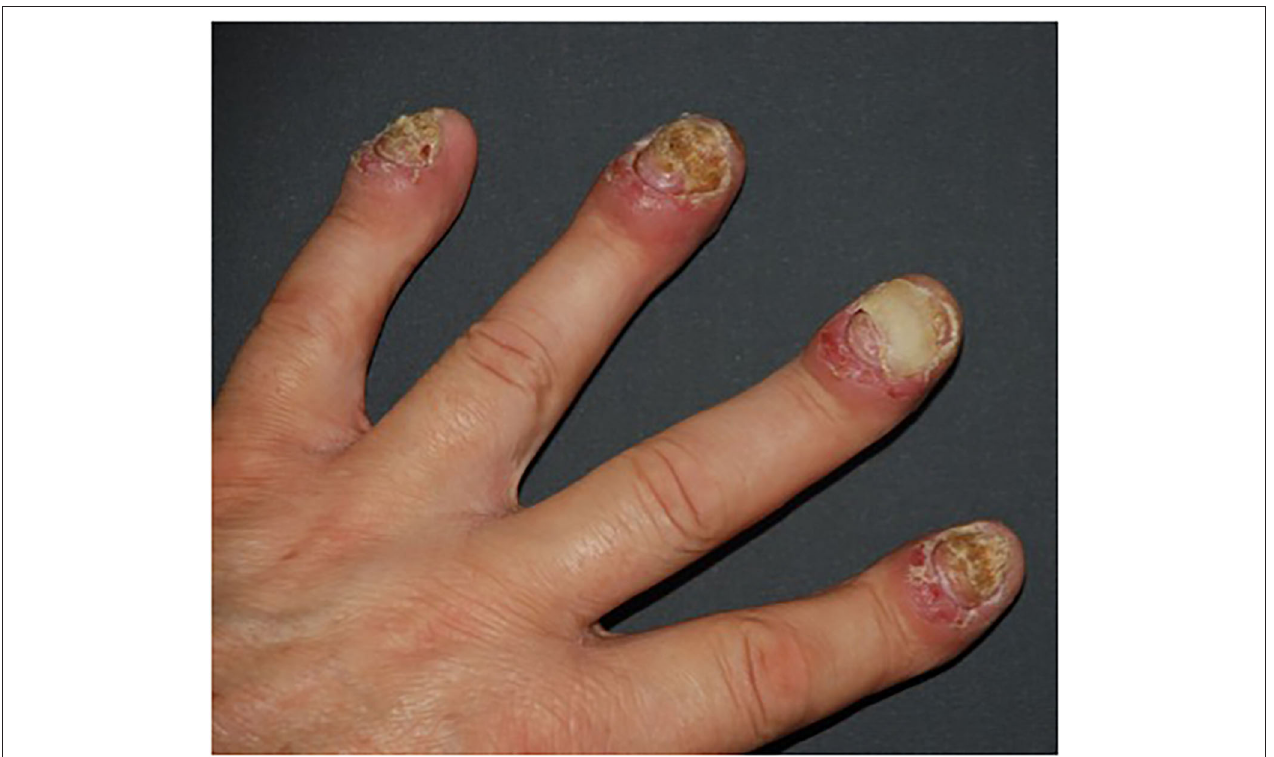
FIGURE 5 | Severe, mutilating nail and finger lesions in acrodermatits continua of Hallopeau. Onycholysis, erythematous-oedematous lesions of distal parts of fingers (from own